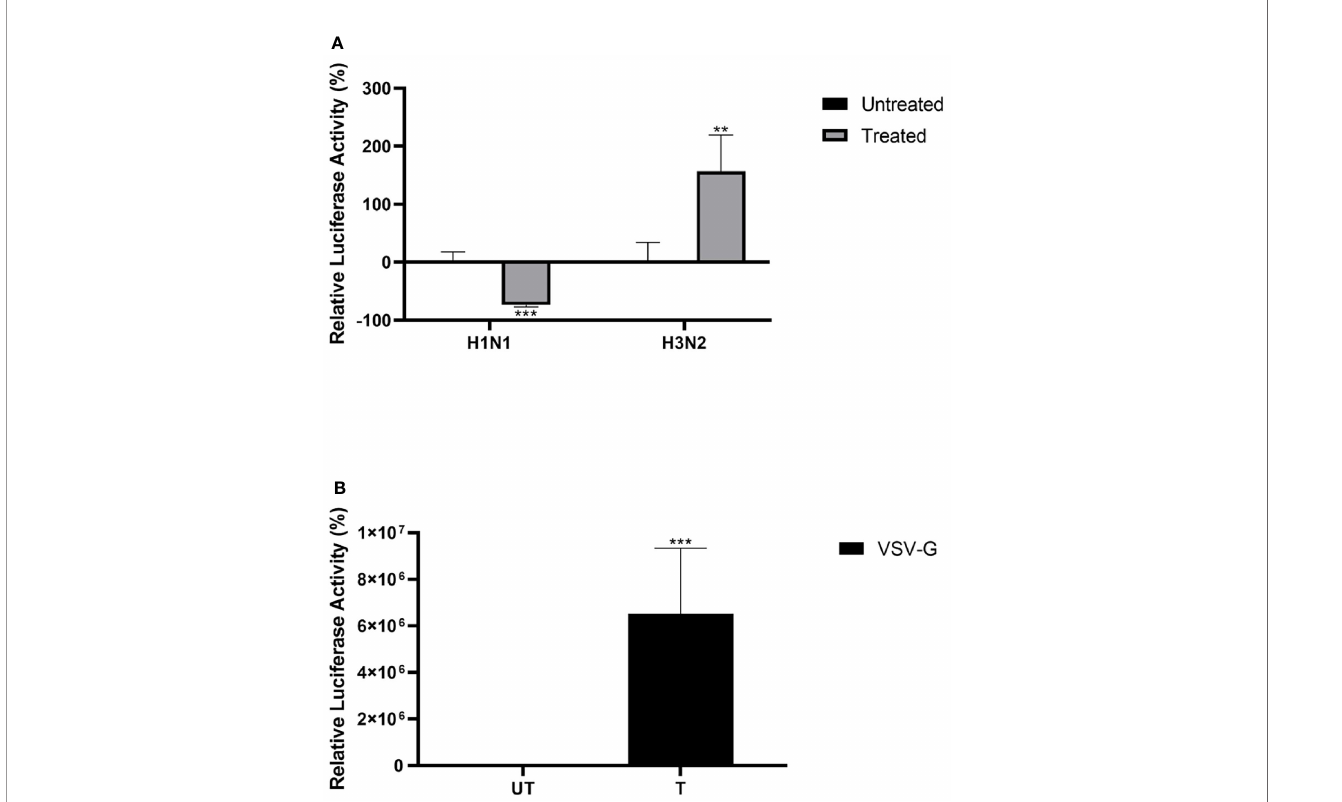
FIGURE 7 | Properdin treatment modulates IAV entry in a subtype-dependent manner. Matched H1N1 or unmatched H3N2 pseudo-typed lentiviral particles were pre-treated with properdin (20 m g/ml) (A) . Luciferase reporter activity of MDCK cells transduced with either treated or untreated pseudo-typed lentiviral particles was measured to study if the treatment affected the ability of the virus to enter the cells. VSV-G pseudotyped lentiviral particles were used as positive control (B) . The background was subtracted from all data points. The data obtained were normalised with 0% luciferase activity being de fi ned as the mean of the relative luminescence units recorded from the control sample (Cells + respective pseudotyped lentiviral particle). Data are shown as the normalized mean of three independent experiments done in triplicates ± SEM. Signi fi cance was determined using the two-way ANOVA test (**p < 0.01, ***p < 0.001) (n = 3).